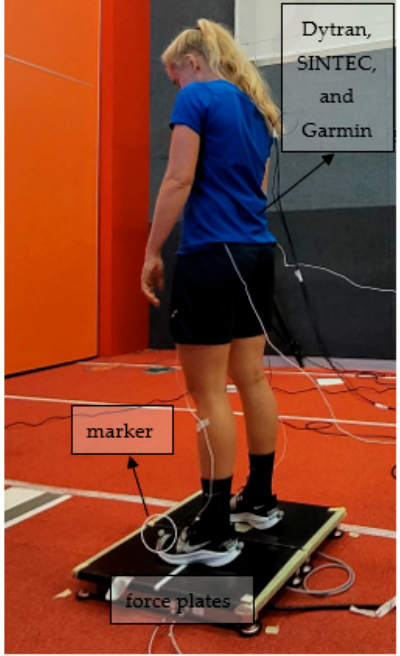
Figure 1. Participants standing on force plates. Dytran accelerometers and S2P bilateral force plates were wired to two synchronized 24-bit Dewe-43 analogue-to-digital converters and DewesoftX data acquisition software (Dewesoft d.o.o., Trbovlje, Slovenia). The Oqus cameras were connected to Qualisys Track Manager (QTM, Qualisys, Gothenburg, Sweden), the Garmin Running Dynamic Pod was connected to a Garmin Forerunner 945, and a smart patch was connected to a custom Windows application (Bio2BITWinApp, STMicroelectronics, Milan,